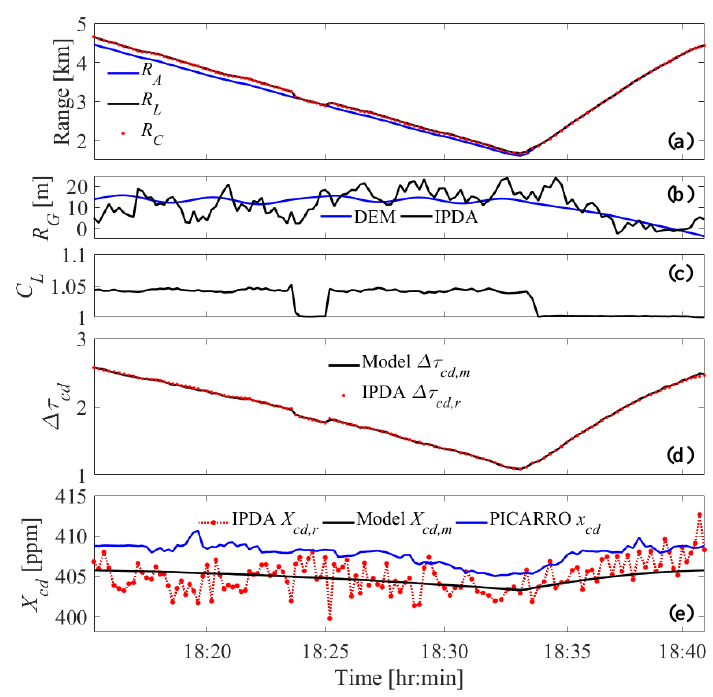
Figure 16. Airborne pulsed 2-μm IPDA lidar measurement and retrieval results during Spiral 1 conducted before sunset. ( a ) Airborne altitude, R A , as compared to LOS, R L and IPDA column measurement, R C . ( b ) Estimated ground elevation, R G , as compared to DEM results. ( c ) Corresponding C L profile used for converting R A to R L . ( d ) IPDA Δ τ cd measurement after processing and 10-s (500 shots) average, Δ τ cd,r compared to model Δτ cd , Δτ cd,m , obtained from MGD. ( e ) IPDA retrieved XCO 2 , X cd,r , compared to model driven XCO 2 , X cd,m and corresponding x cd in situ measurements. Results obtained using 2 GHz and 5 V e-APD bias voltage.